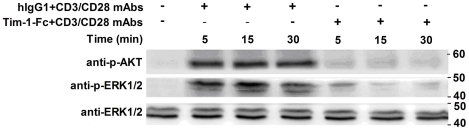
Tim-1-Fc inhibits AKT and ERK1/2 phosphorylation in mouse T cells.C57BL/6 mouse CD4+ T cells (2×106/well) were stimulated by anti-CD3 (2 µg/ml) and anti-CD28 (1 µg/ml) mAbs plus 10 µg/ml Tim-1-Fc or control human IgG1 for indicated times. Whole-cell lysates were analyzed for kinase phosphorylation by western blotting. Data were representative of three separate experiments.